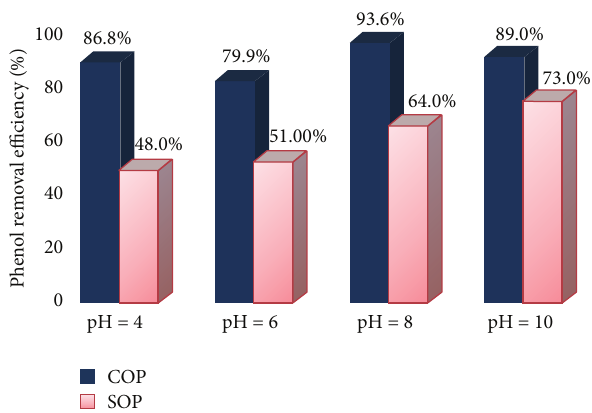
Figure 1: Effect of initial pH on removal efficiency of